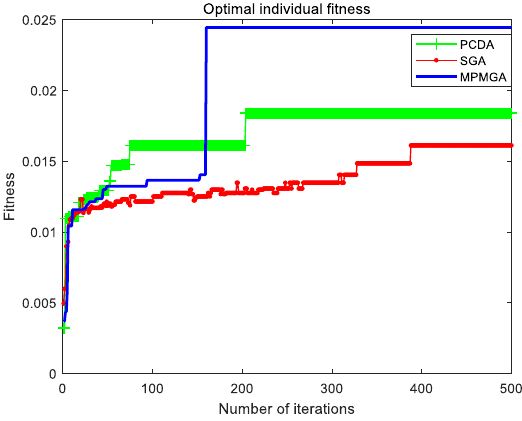
Figure 21. Evolutionary comparison diagram of optimal individual fitness.